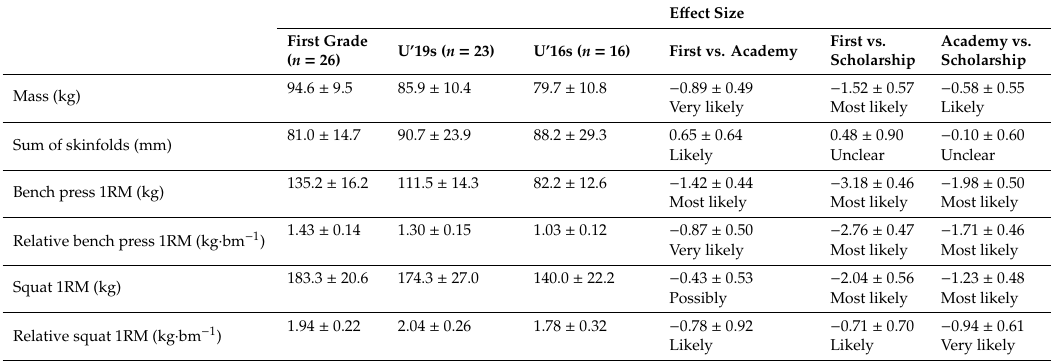
Table 1. Biometric characteristics (mean ± SD) of the first team, academy, and scholarship